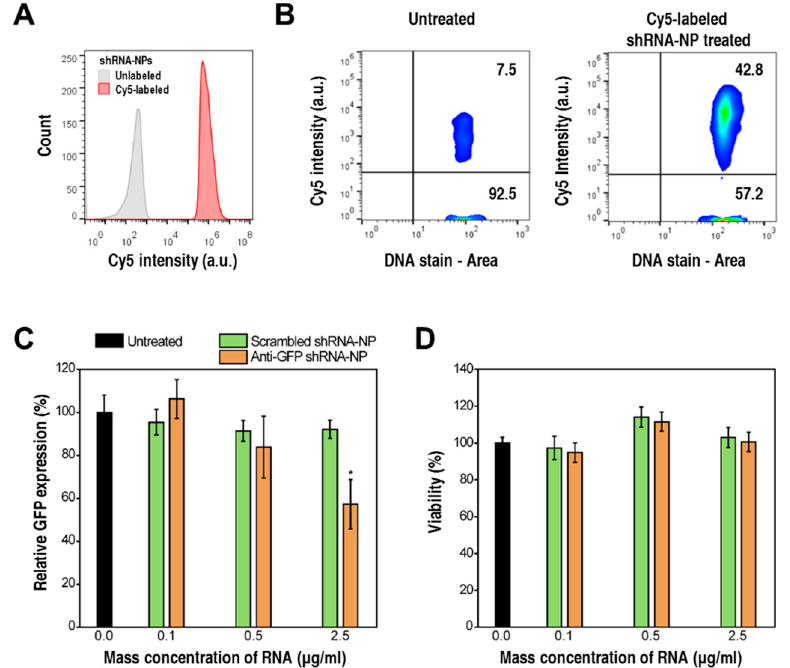
Figure 3. ( A ) Cytometry analysis of unlabeled (gray) and cy5-labeled shRNA-NPs, showing that fluorescent labeling of shRNA-NPs was successfully carried out. ( B ) Cellular-uptake analysis of HeLa cells treated with unlabeled or cy5-labeled shRNA-NPs. ( C , D ) Relative GFP expression ( C ) and cell viabilities ( D ) of HeLa-GFP cells treated with various concentrations of negative control (green), anti-GFP shRNA-NPs (orange), or left untreated (black) at 24 h after the treatment (* p < 0.05).